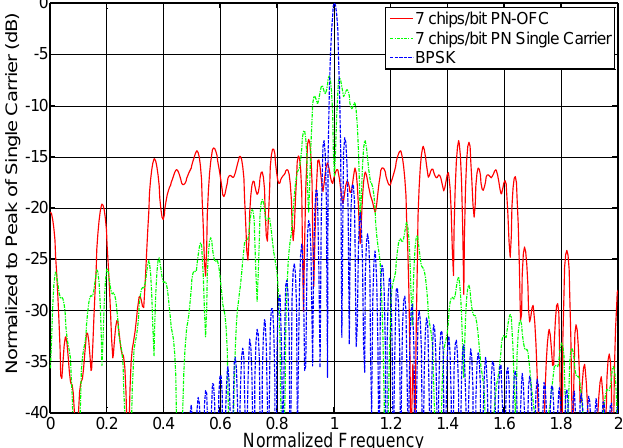
Figure 8. Frequency responses of seven chip OFC, seven chip Barker code, and single frequency carrier (BPSK), each with identical time